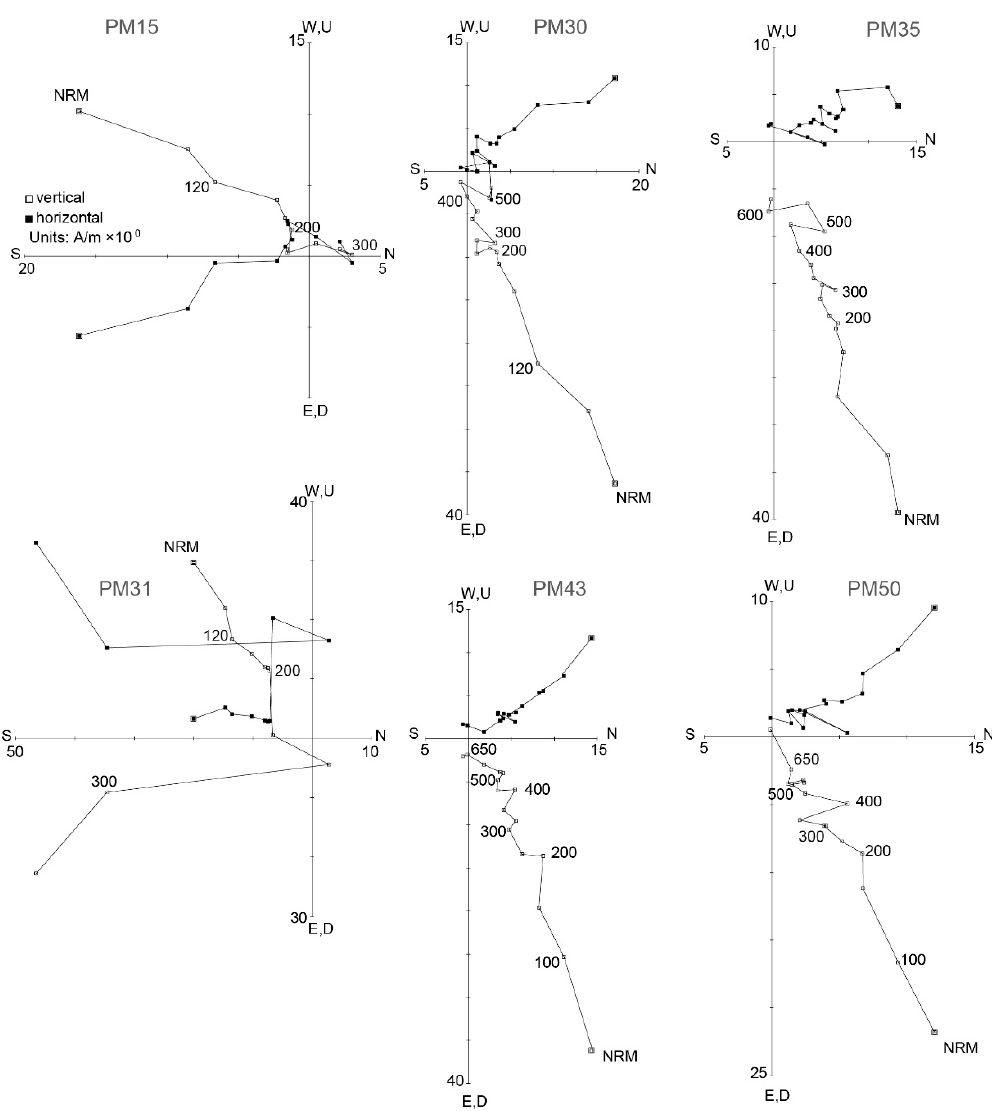
Figure 6. Vector end-point demagnetisation diagrams for representative samples (see Figure 3c for stratigraphic position) in in situ coordinates. Closed (open) squares are projections onto the horizontal (vertical) plane.